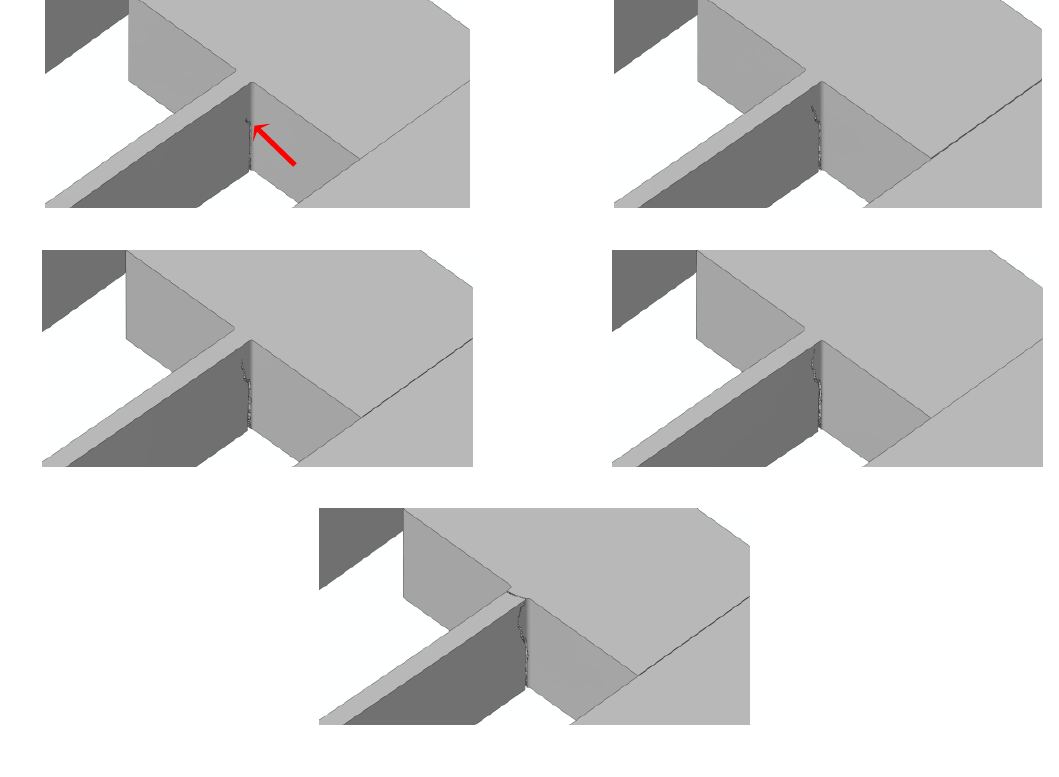
= 100 nm: forecasted crack e